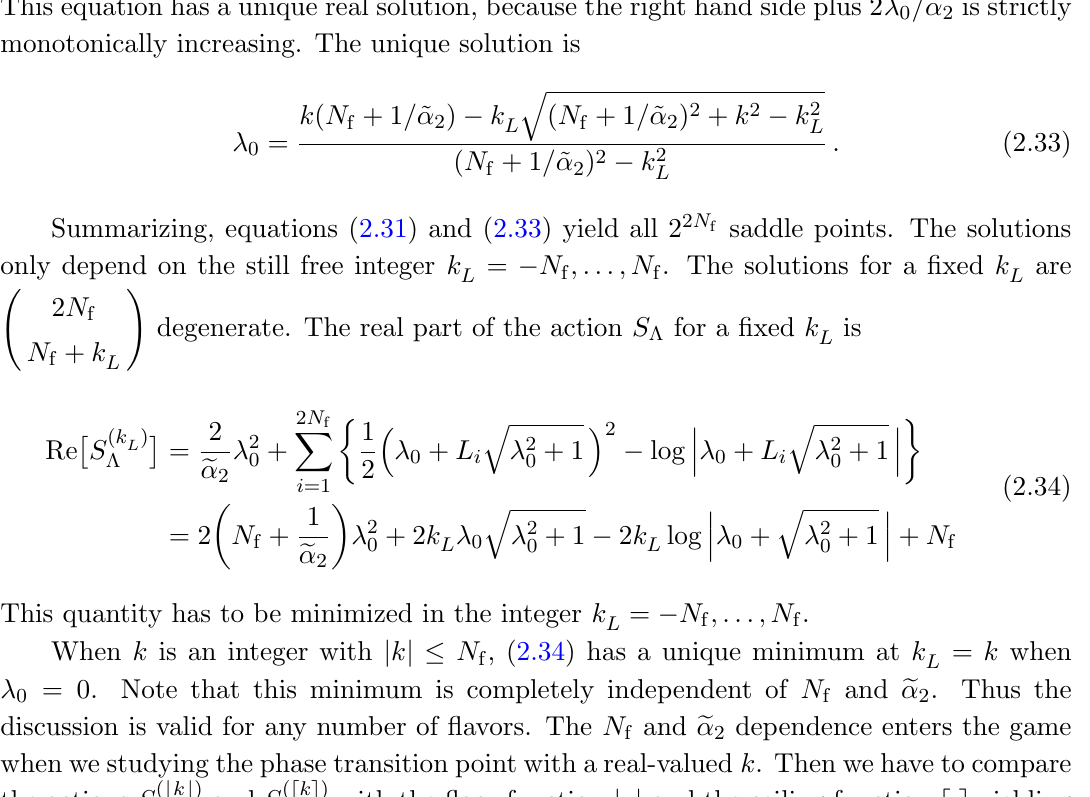
= ~ (cid:11) is strictly 0 2